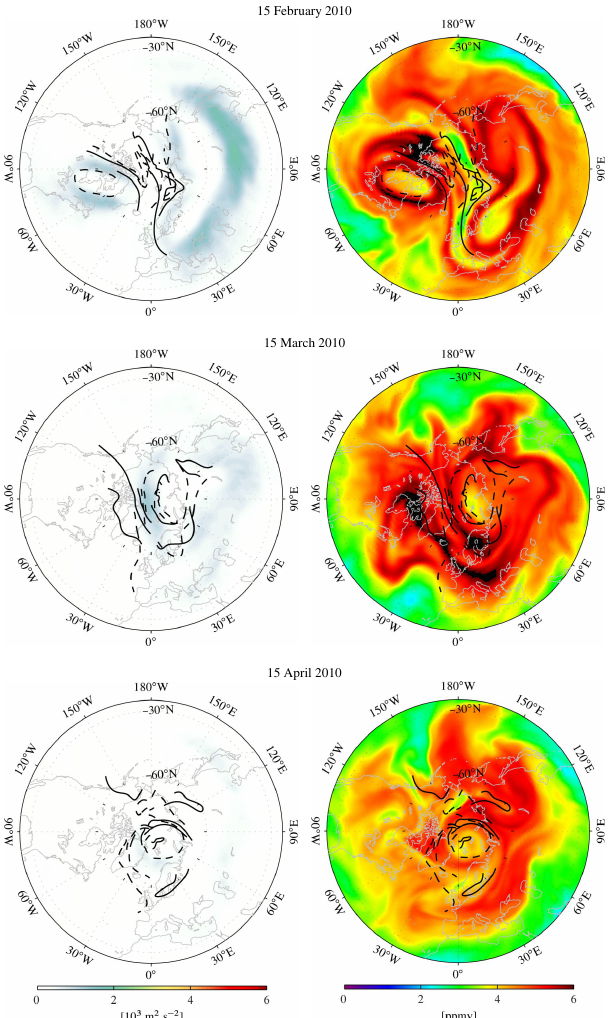
Fig. 3. Same as Fig. 1, but over the boreal polar region on three days in